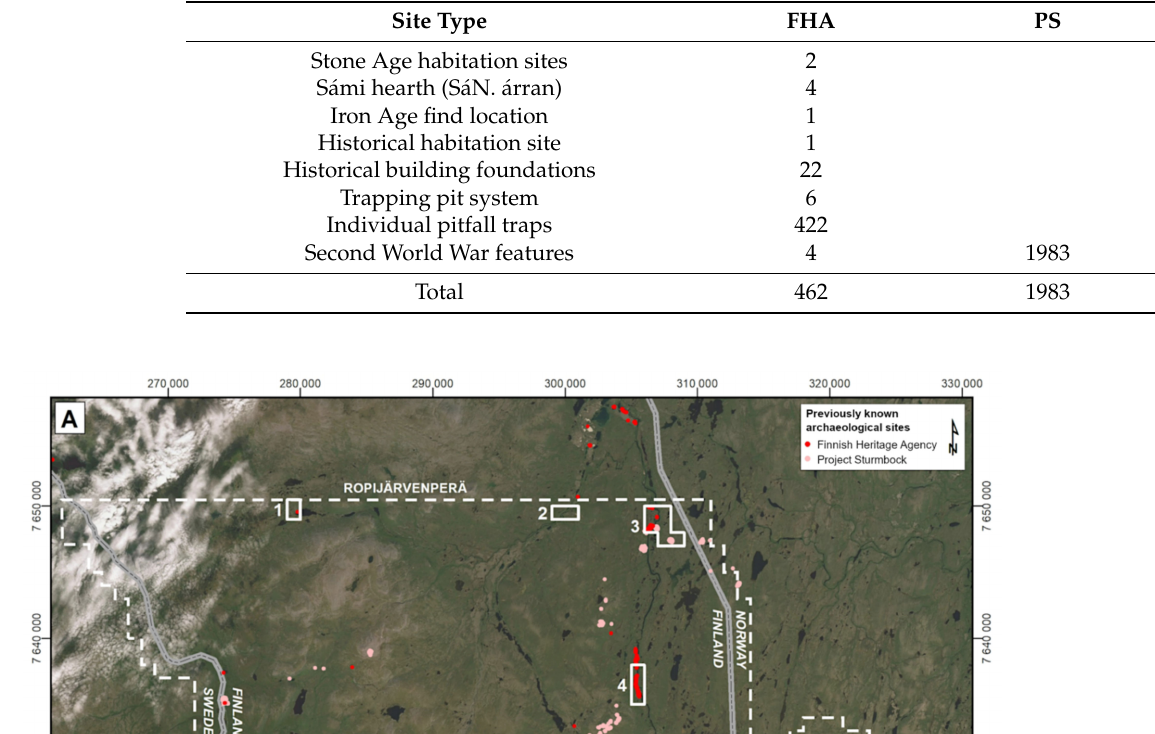
Table 2. Archaeological sites registered from the Ropijärvenperä production area by January 2021 (FHA = Finnish Heritage agency; PS = Project Sturmbock).